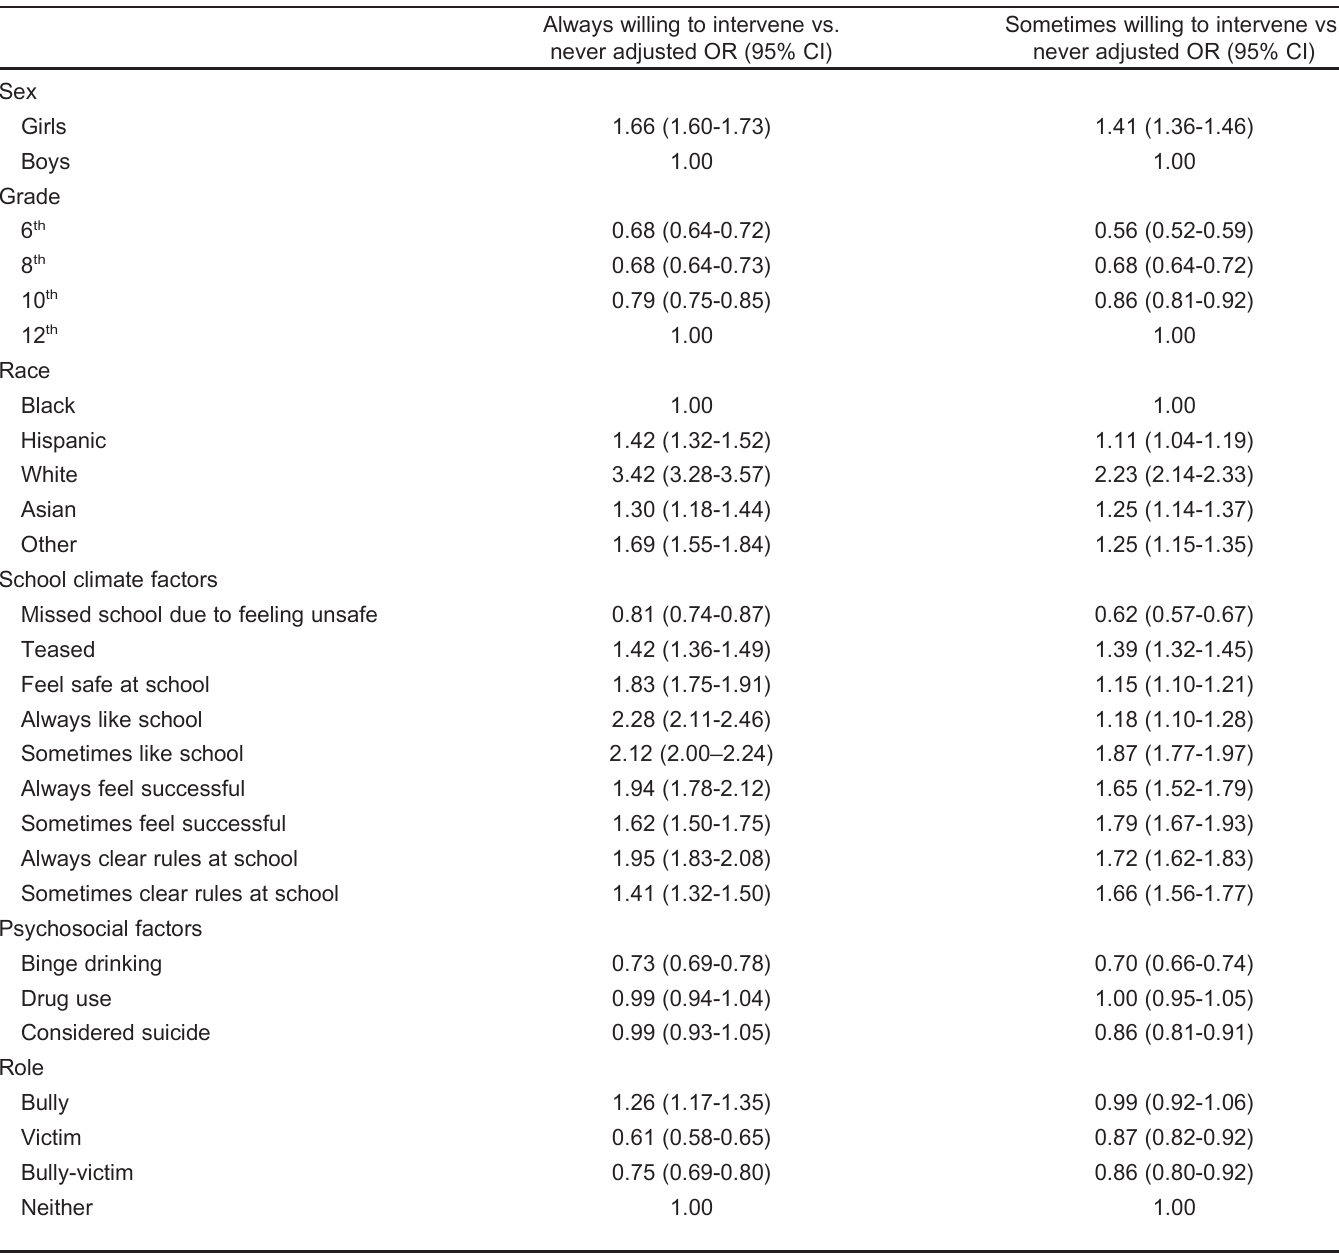
Table 2. Demographic, school climate and psychosocial factors and their association with willingness to intervene in a bullying incident among participants in the Georgia Student Health Survey II (2006). Always willing to intervene